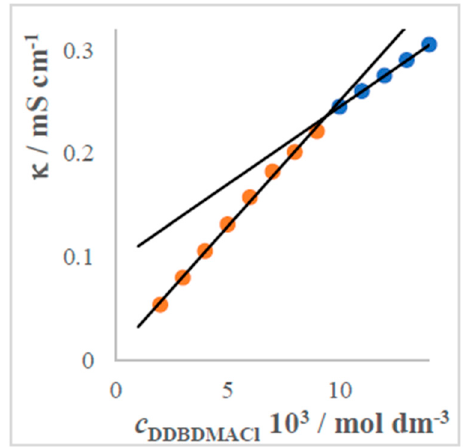
Figure 2. Conductivity versus molarity curves for binary system DDBDMACl (V)–water at temperature 45 °C. Table 2. Calculated values of critical micellar concentrations (CMC) of all studied surfactants at temperature 20–50 ◦